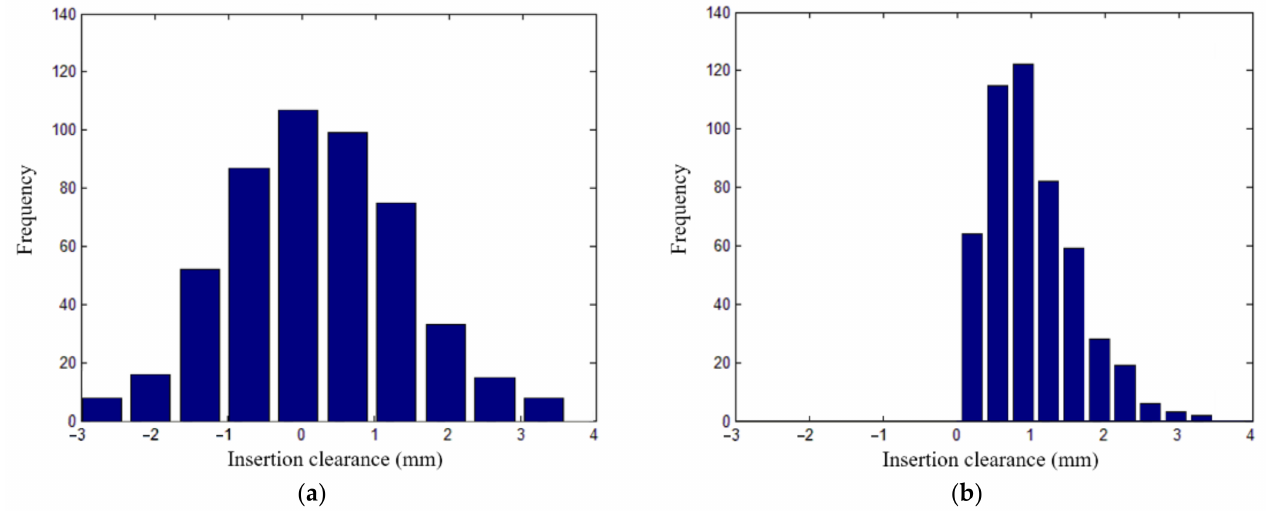
Figure 15. Error frequency distribution of the insertion clearances in key blocks after optimization of the assembly measures. ( a ) Insertion clearance of block F. ( b ) Insertion clearance of block LZ. (2)